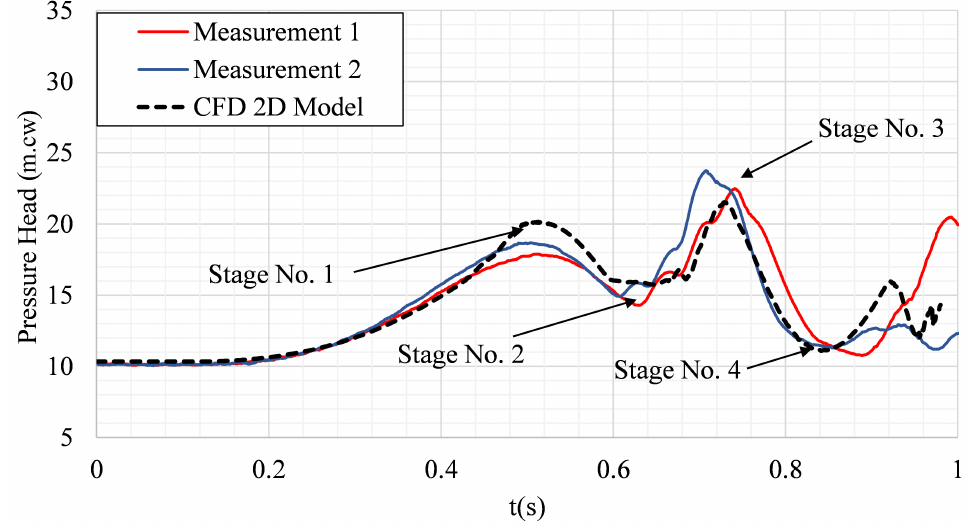
Figure 5. Conceptualisation of the uncontrolled filling process of experimental test